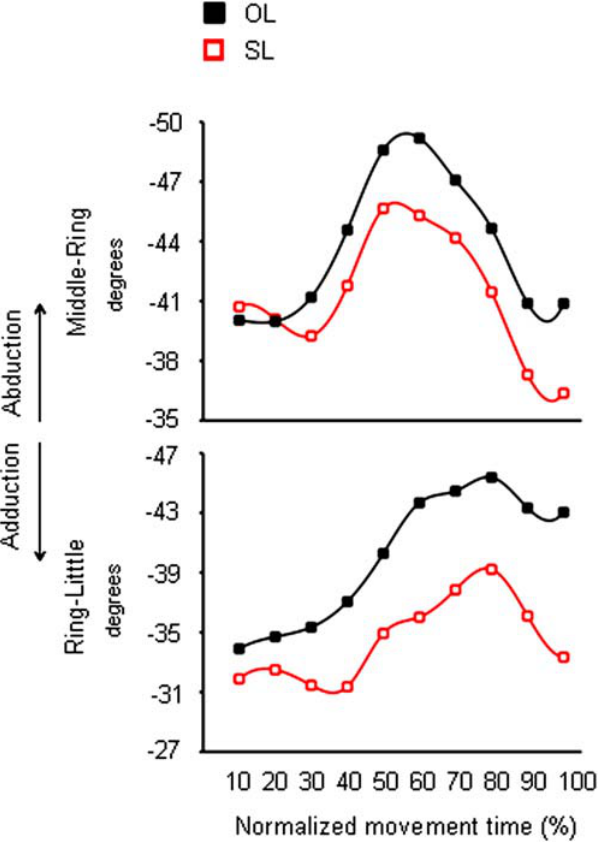
Figure 7. Time course of abduction angle between fingers during reaching for the large target either in the absence or in the presence of an odour evoking a small object. Each trace denotes average abduction angle of a representative subject (Subject 10) for the middle-ring and the ring-little fingers when performing the ‘OL’ (black squares) and the ‘SL’ (red squares) conditions. Increase in negative values correspond to bigger abduction (i.e., increase of digits’ angular distance). OL=Odourless air-Large target; SL=‘Small’ odour- Large target.